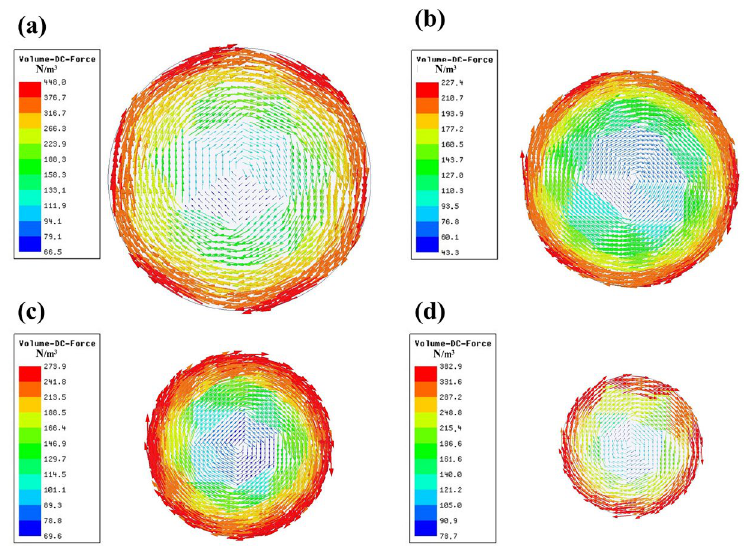
Figure 11. Vector diagram of the electromagnetic force on the strand cross-section in the center of the stirrer: ( a ) Φ650 mm; ( b ) Φ550 mm; ( c ) Φ450 mm; ( d ) Φ350 mm. In the actual production of round blooms in the plant, M-EMS needs to adapt to four types of the strand with section sizes of: Φ650 mm, Φ550 mm, Φ450 mm , and Φ350 mm . The thicknesses of the copper tube for each section are: 31 mm, 29 mm, 25 mm, and 25 mm, respectively. The horizontal installation position of the M-EMS designed according to the maximum section Φ650 mm is fixed with the outer arc as the reference line, which results in a large deviation between the central axis of the strand with a smaller diameter and the central axis of the M-EMS as shown in Figure 12.